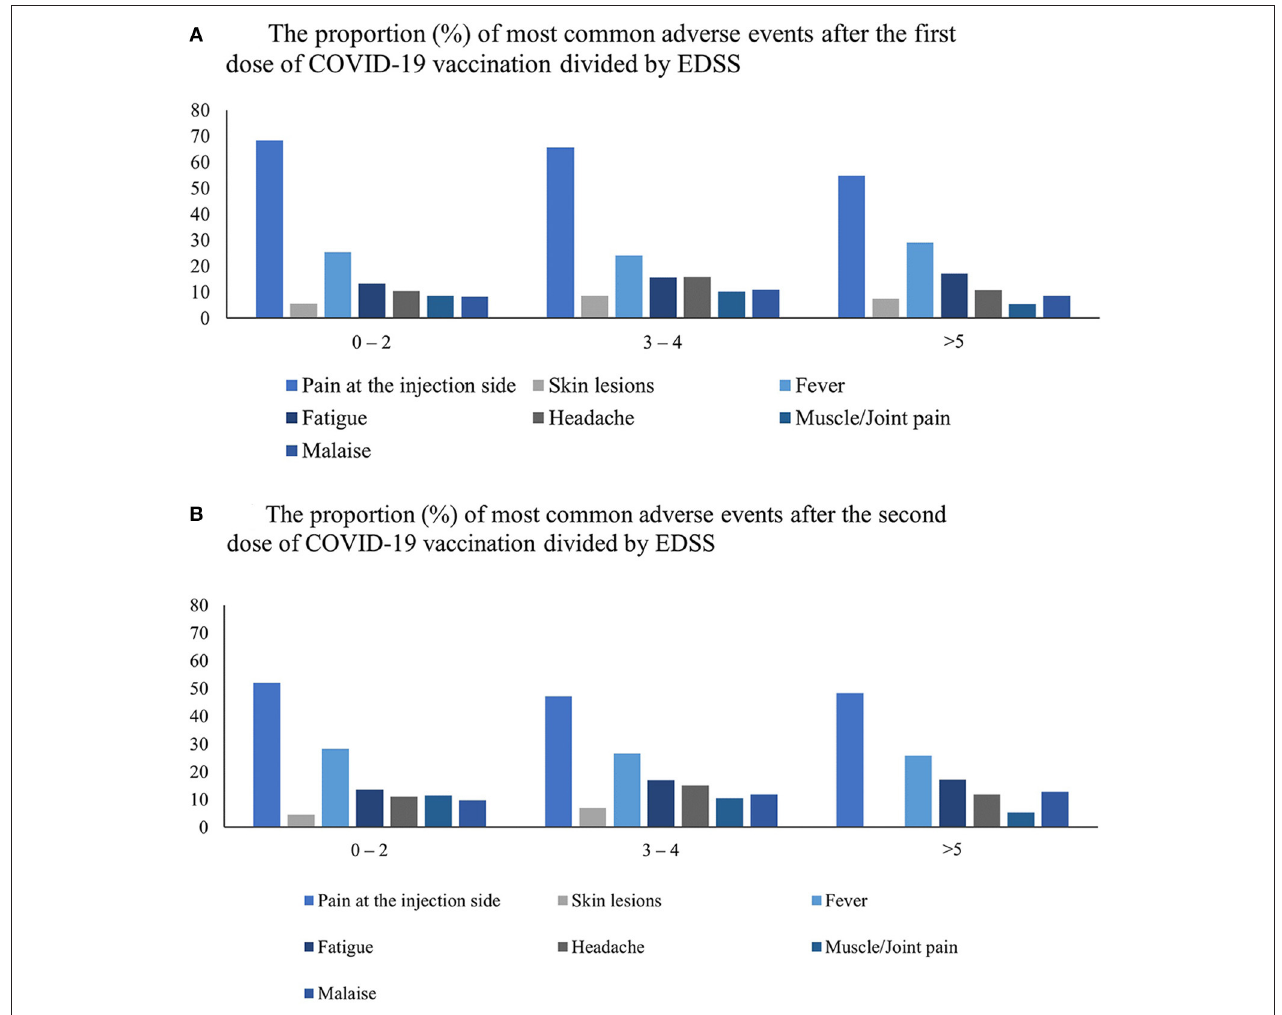
FIGURE 4 | The proportion (%) of most common side effects after COVID-19 vaccination among the cohort was divided by three categories of disability assessed by EDSS after the first (A) and the second dose (B) .